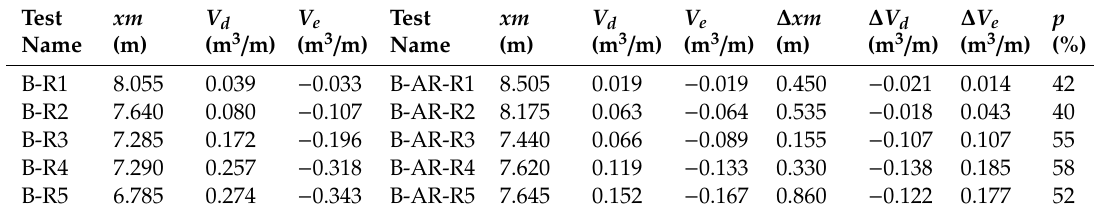
Note: The integral range of V e is from xm and xs , and the unstable part of the reverse slope at the scarp is regarded as the erosion part before avalanching, leading to the larger magnitude of V e than V d . Table 3. The final volume changes of the lower and upper parts of the evolved profile relative to the initial profile under regular waves ( xm is the intersection of the initial and final slopes; V d and V e are the volume changes of the lower and upper parts, which are positive and negative, indicating deposition and erosion; ∆ xm , ∆ V d , and ∆ V e are the di ff erence between the variables in B and B-AR tests under specific wave climate; p is the percentage of the decreased erosion volume defined as ∆ V e divided by V e in B tests.).